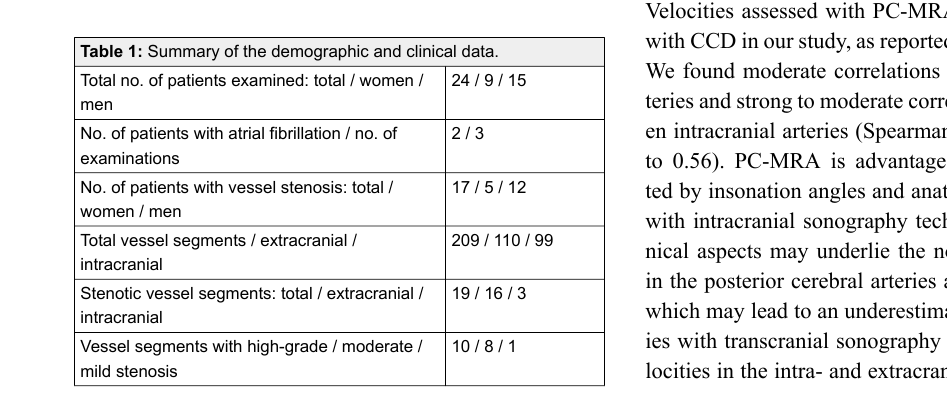
Table 2: Mean values and velocity differences (Δ) for peak systolic velocities (PSV) and end diastolic velocities (EDV) acquired with color coded duplex (CCD) sonography and phase contrast magnetic resonance angiography (PC-MRA). PSV (cm/s)